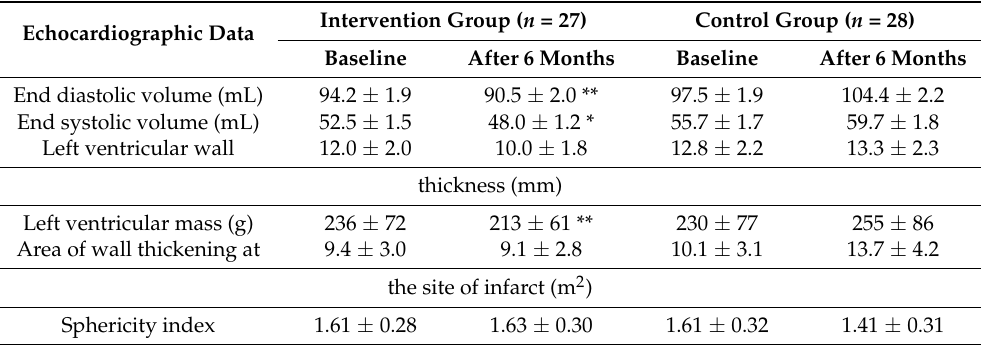
Table 4. Changes in left ventricular dysfunction on two dimensional echocardiography.